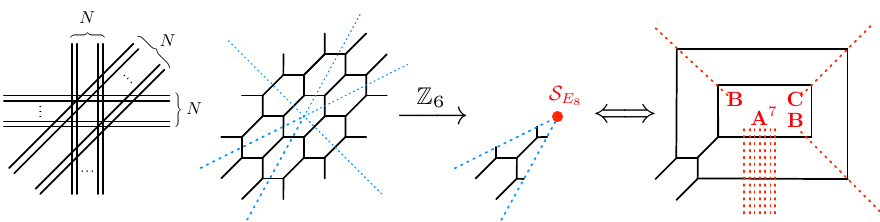
Figure 17 . (cid:30) + N -theory, which is of Z 6 symmetry (which also has Z 2 , Z 3 ). The Z 6 quotient of the (cid:30) + -theory, [2] − SU(3) − SU(4) − SU(3) − [2] , becomes 5d Sp(2) + 1 AS + 7 F 2